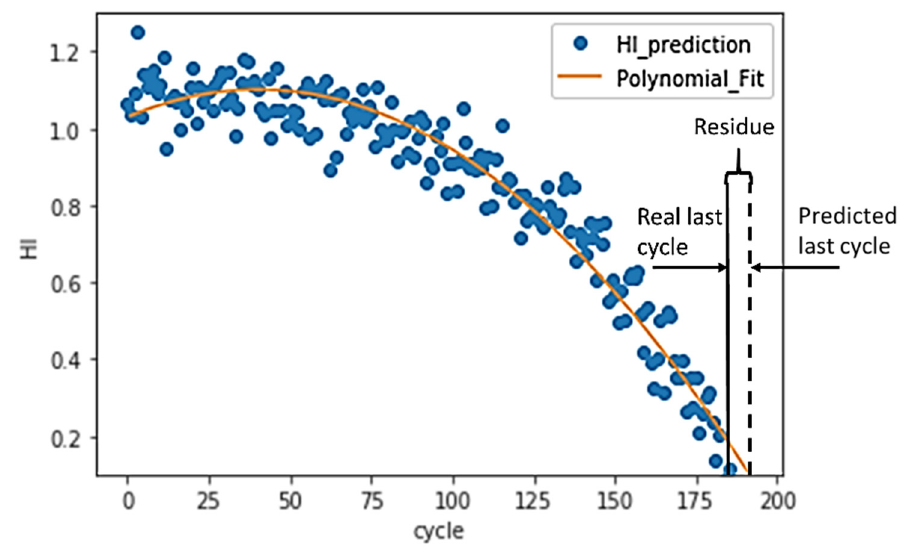
Figure 12. Accuracy of RUL prediction.